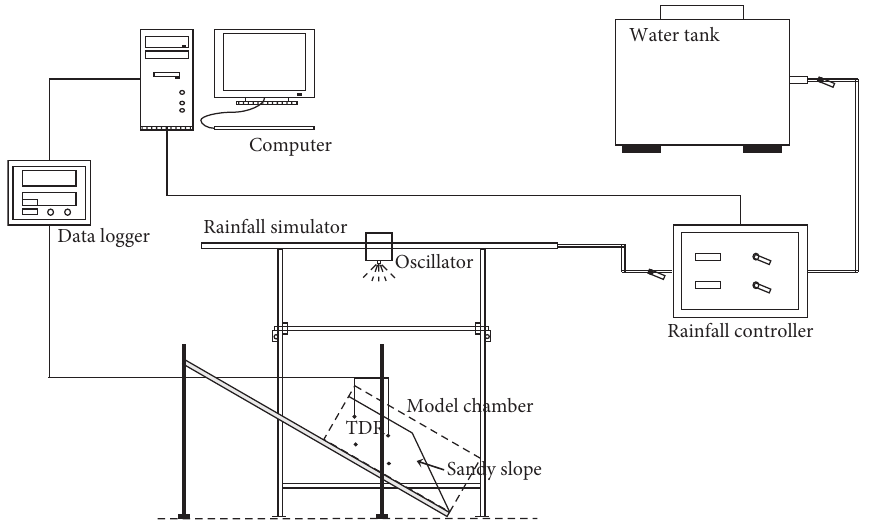
Figure 1: Schematic diagram of the model test apparatus.